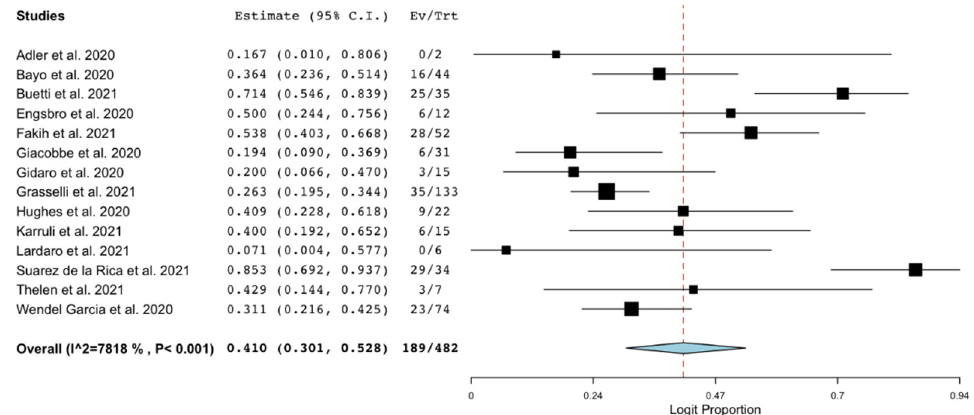
Figure 3. Mortality of patients with COVID-19 and bloodstream infection. Forest plot with the result of single-arm meta-analysis for mortality of patients with COVID-19 and BSI. BSI, bloodstream infection; CI, confidence interval; Ev, events; Trt, total.